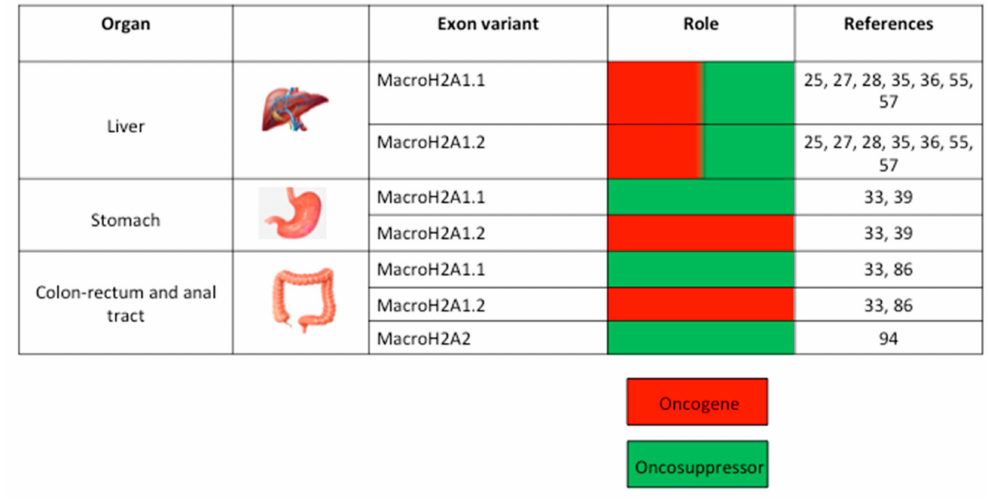
Figure 2. Representation of the role of macroH2A histone variant family members (macroH2A1.1, macroH2A1.2, macroH2A2) in tumorigenesis in di ff erent parts of the gastrointestinal (GI)